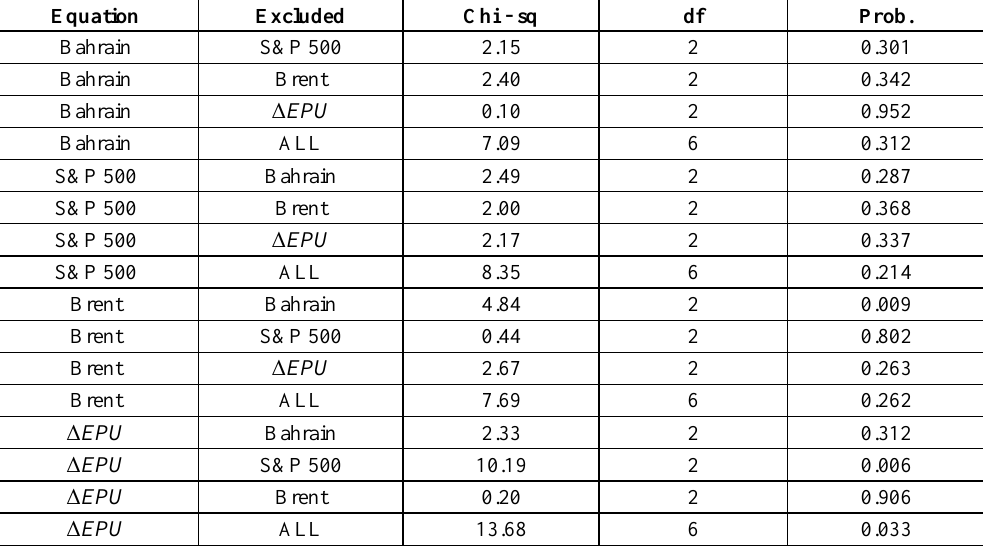
Table 5. Granger Causality Wald Tests